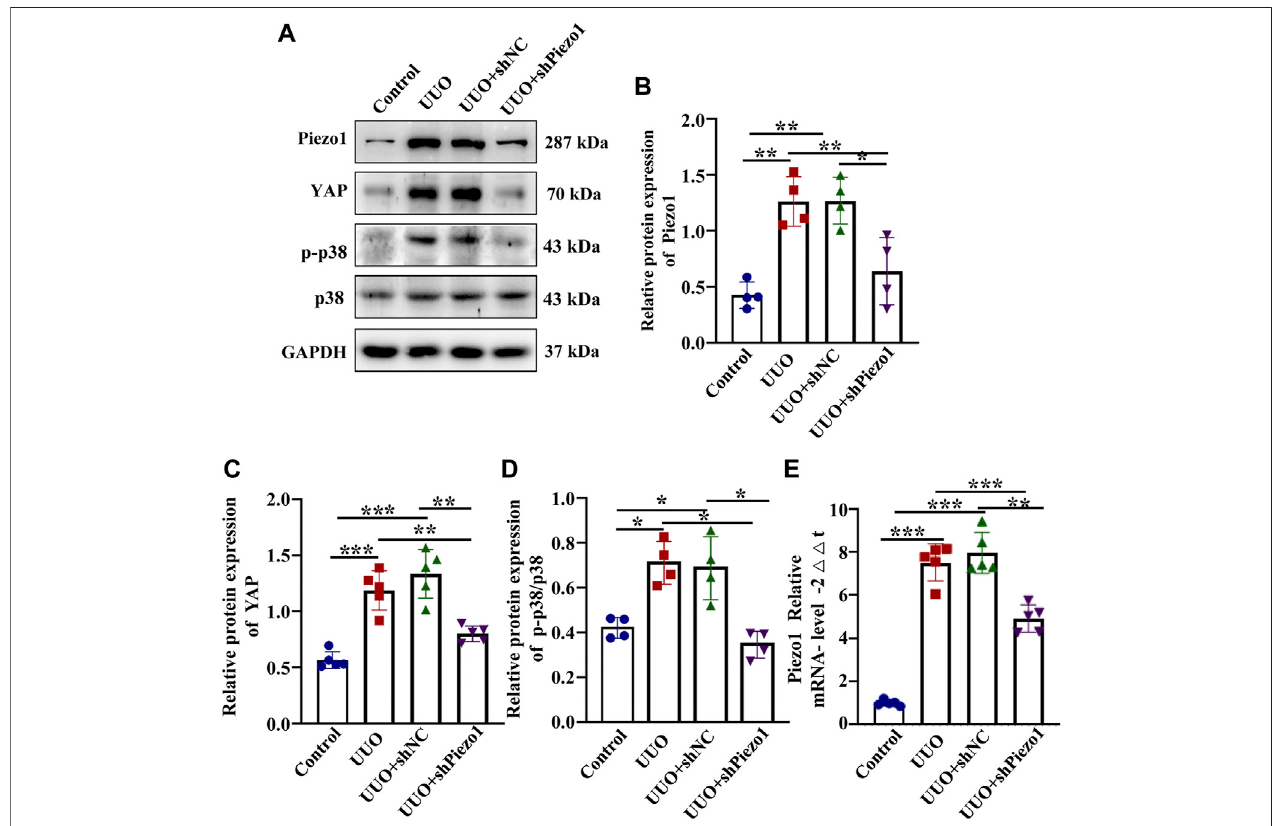
FIGURE 10 | Piezo1 knockdown alleviates renal fi brosis through p38MAPK-YAP pathway. An animal model of renal fi brosis induced by UUO was established and a loss-of-function experiment was carried out by using shRNA of Piezo1 and shNC in UUO mice. (A) Representative western blot bands show the protein expression of Piezo1, p-p38, p38 and YAP in four different treatment groups. The bar graph shows the result of semi-quantitative measurement of Piezo1 (B) , p-p38/p38 (C) and YAP (D) ( n (cid:1) 4; * p < 0.05, ** p < 0.01, *** p < 0.001). (E) Relative mRNA expression of Piezo1 in four different treatment groups. ( n (cid:1) 5, * p < 0.05, ** p < 0.01, *** p < 0.001).